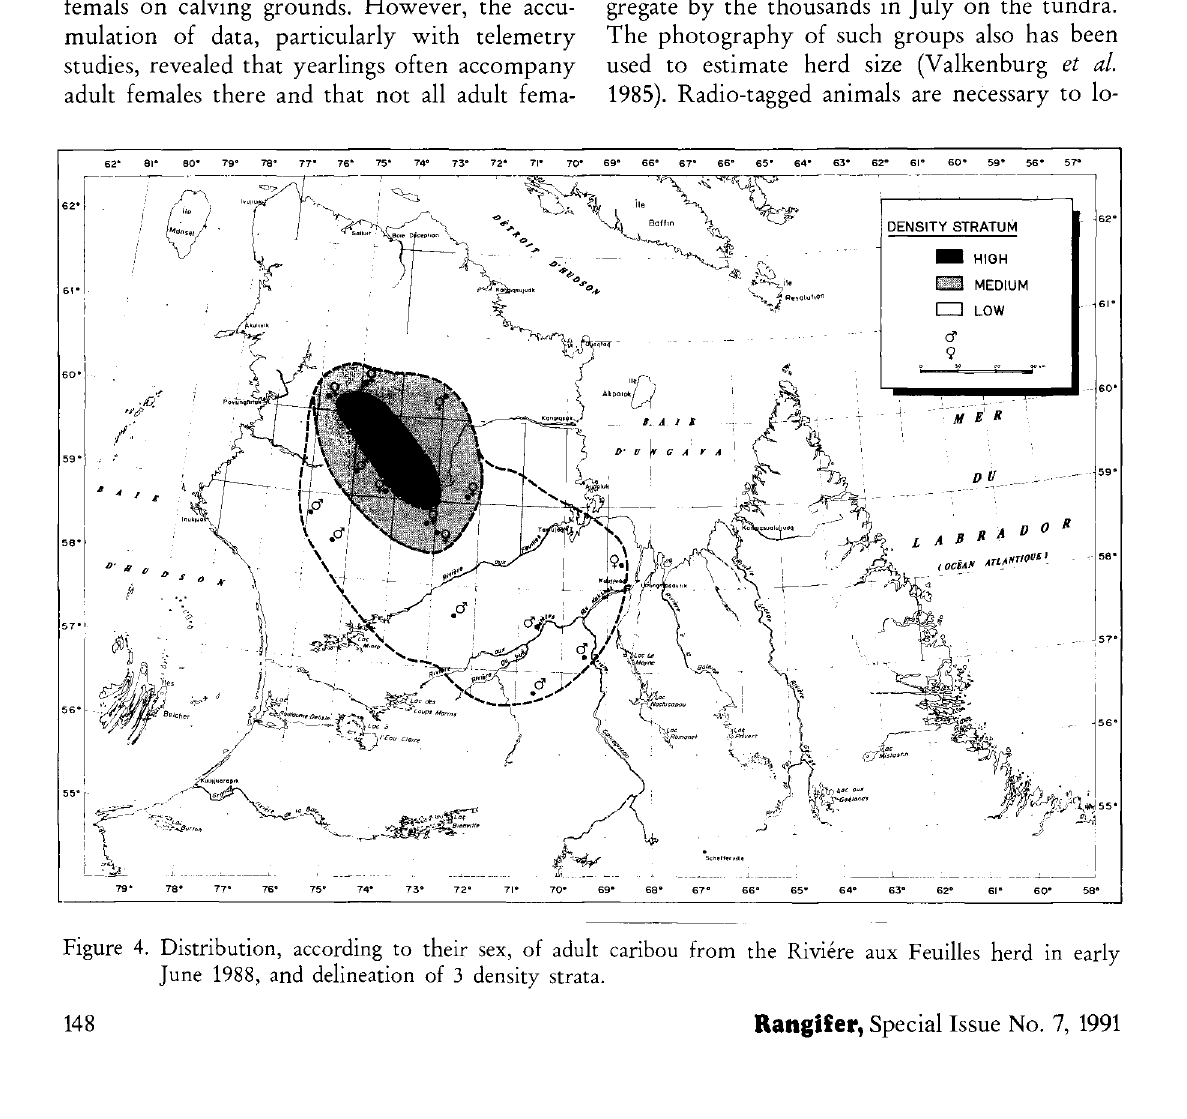
Figure 4. Distribution, according to their sex, of adult caribou from the Riviere aux Feuilles herd in early June 1988, and delineation of 3 density